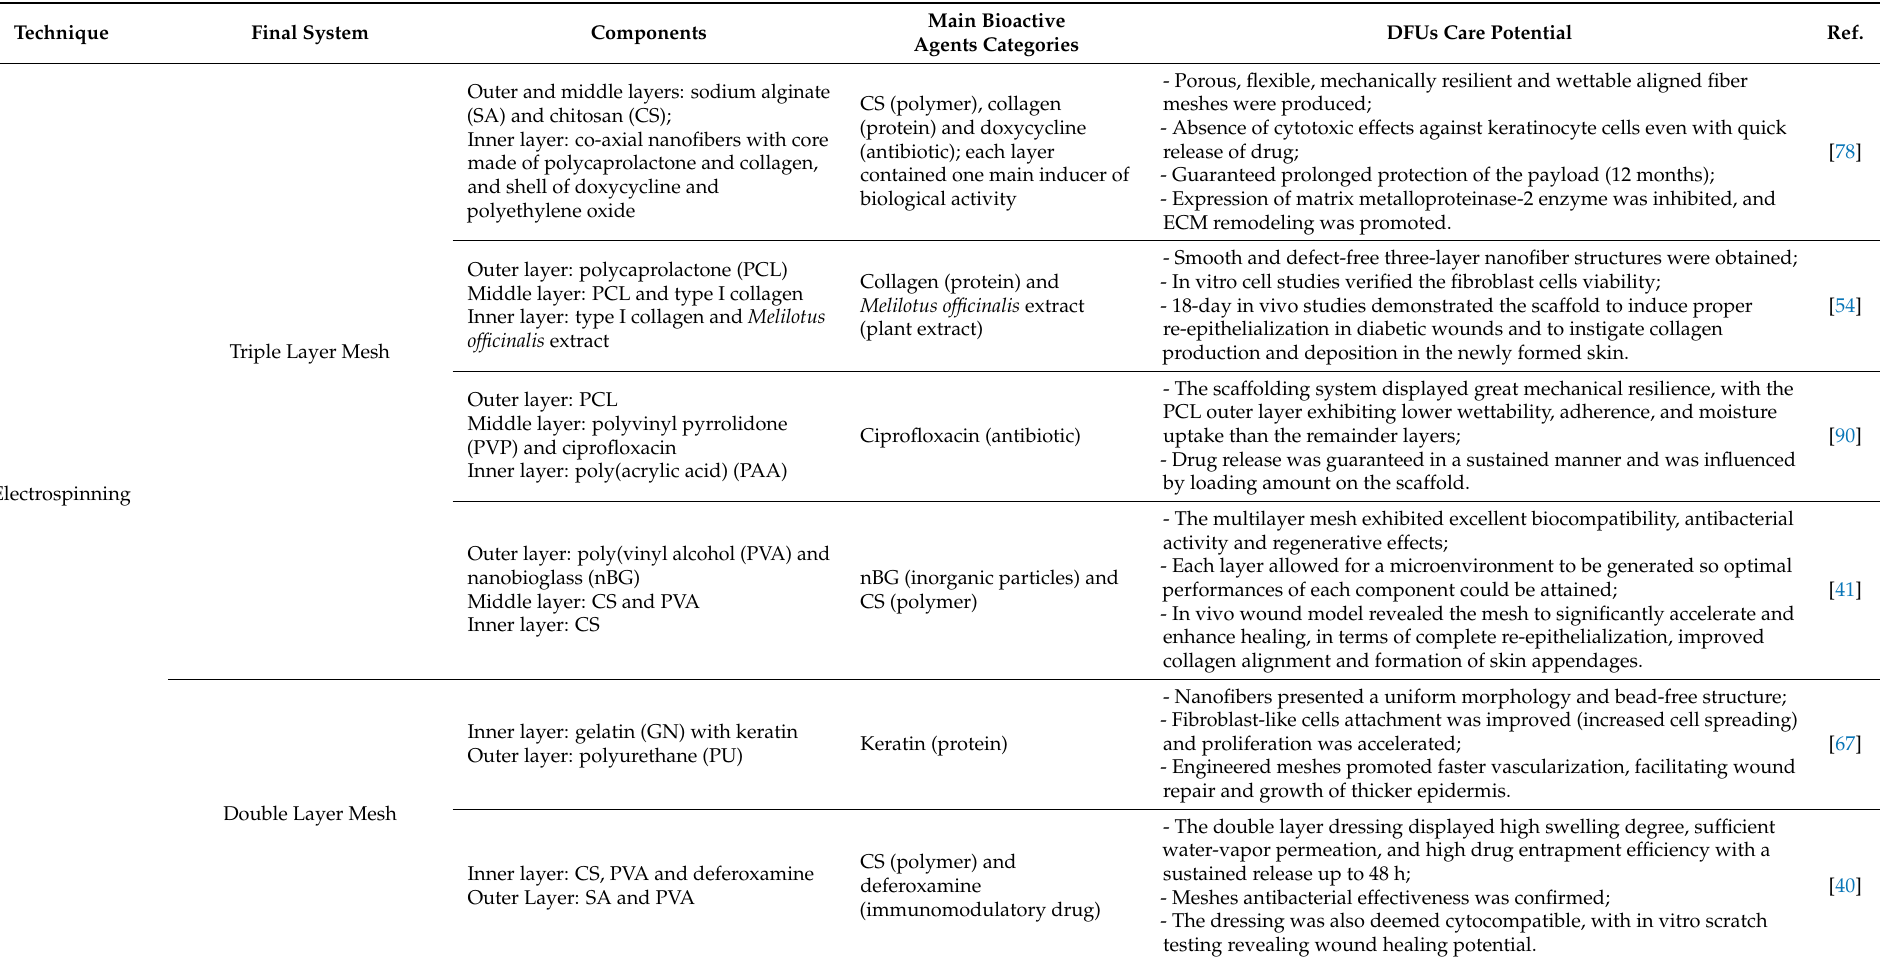
Table 1. Examples of fiber-based systems containing bioactive components of different origins with potential for applications in DFU care and detailed analyses